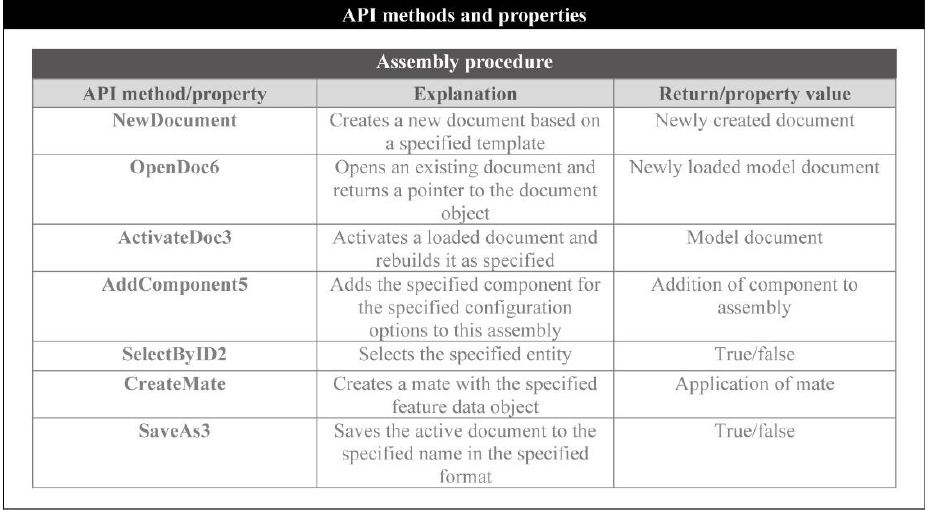
Figure 4. API methods and properties used for the design procedure.